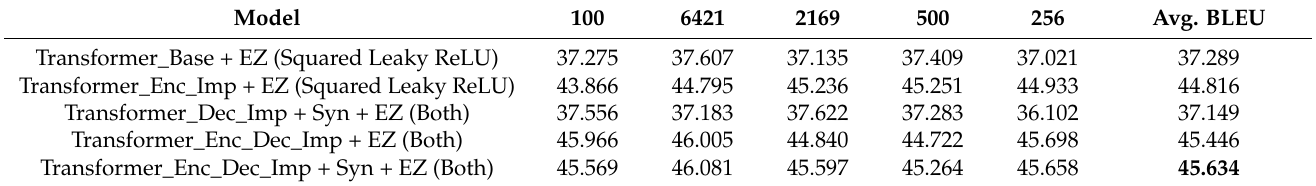
Table 6. BLEU evaluation of five-layer models with fused Primer-EZ on different random seeds.